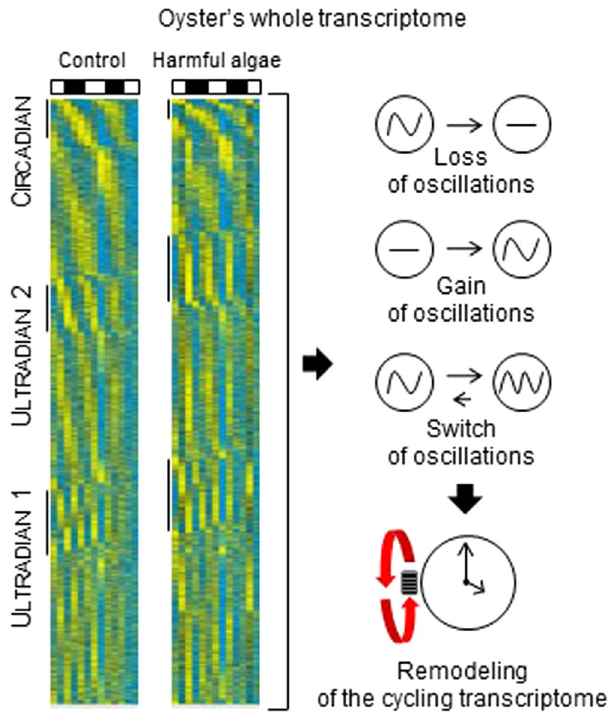
Figure 7. Remodeling of cycling transcriptome. Heat map expression of the whole transcriptome (20,846 transcripts), organized by significance, phase, and period in H.t and A.m respectively. Significant circadian, U1, and U2 transcripts are highlighted by a line in each condition. A summary of remodeling processes due to A. minutum exposure is presented on the